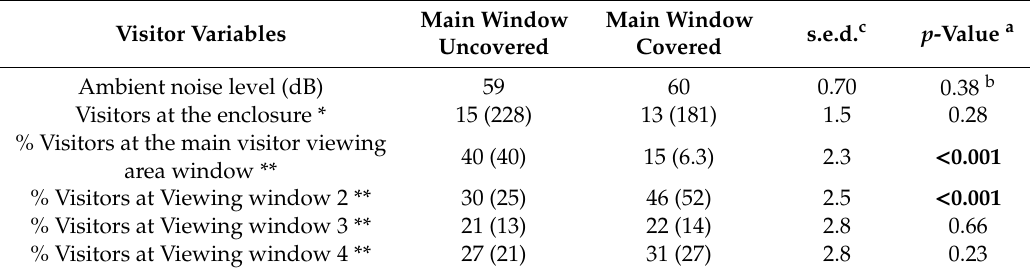
Table 3. E ff ects of treatment on ambient noise level and visitor numbers at the penguin enclosure. The means are the mean noise level and number of visitors at the enclosure each day (per six 30 min observation blocks each day). The proportion of visitors at each visitor viewing area window are also shown. Back transformed means are presented in parentheses and any statistical significance ( p < 0.05) are